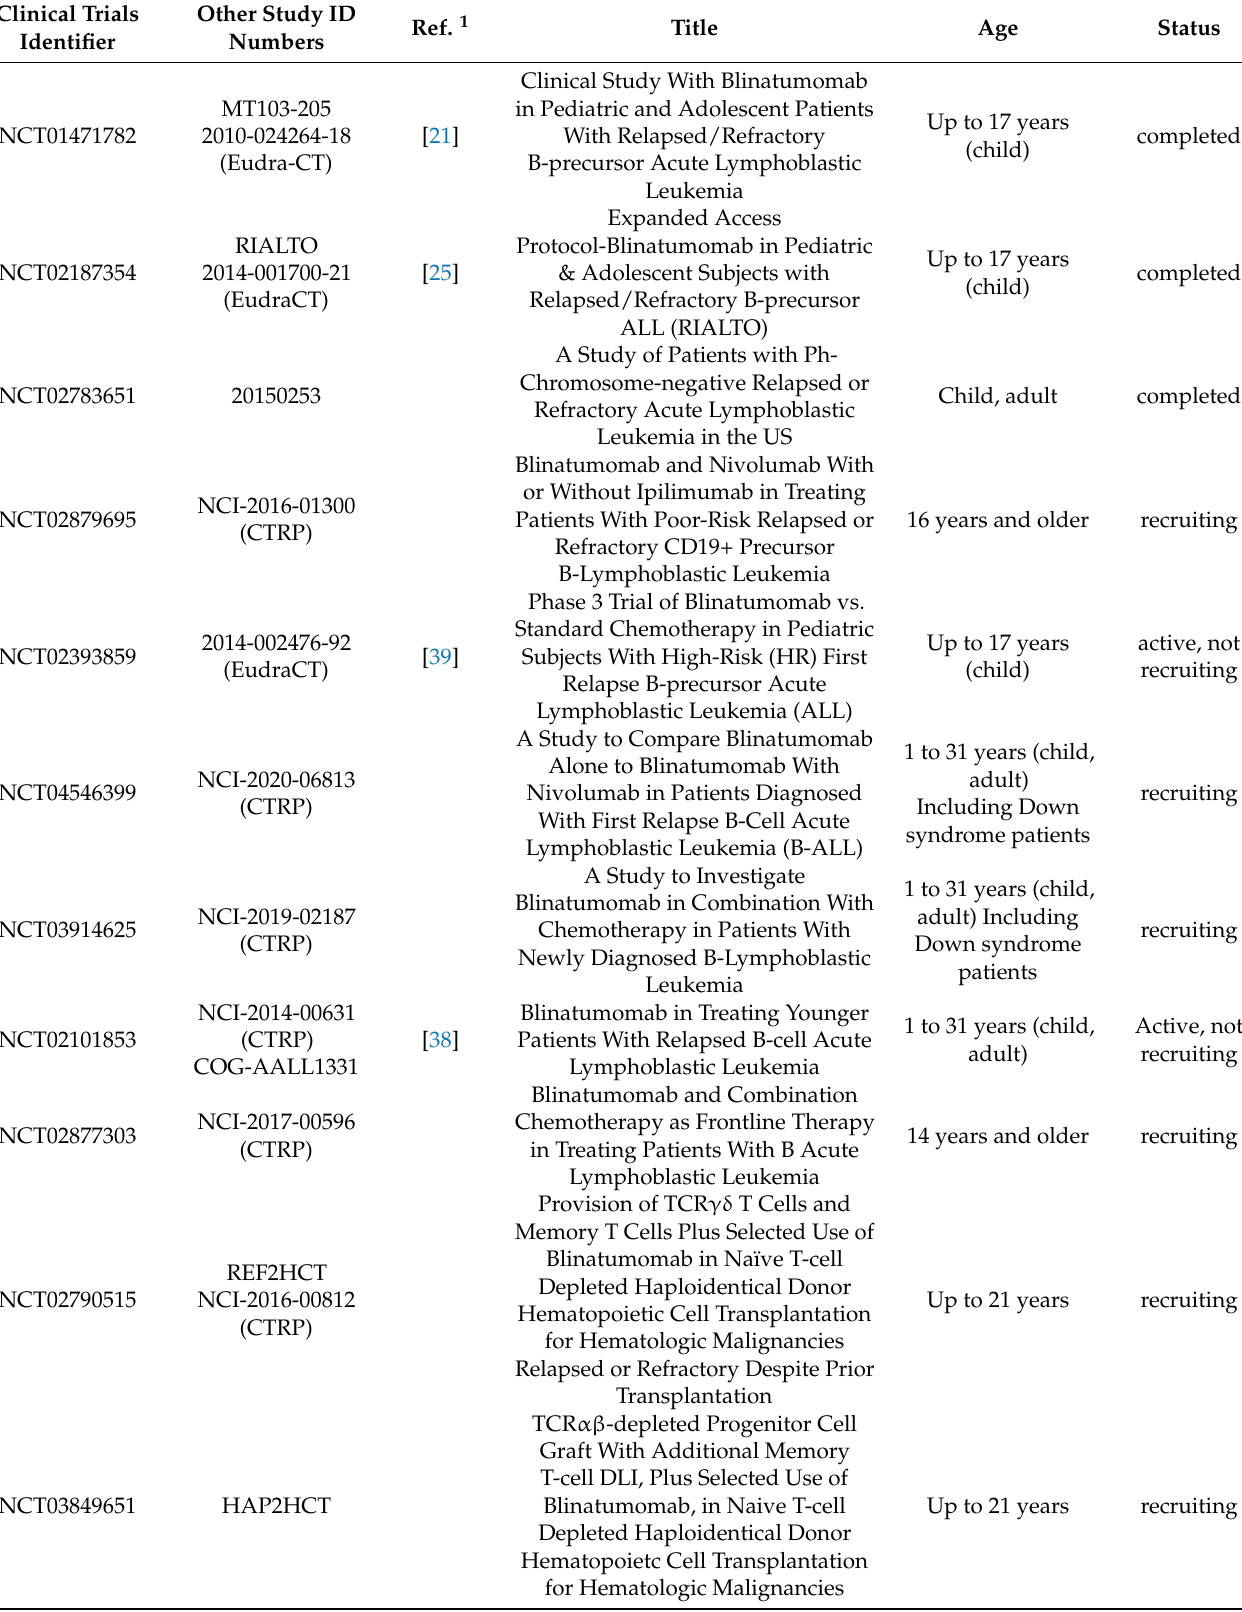
Table 2. Table containing all ongoing clinical trials with blinatumomab for pediatric patients. Clinical